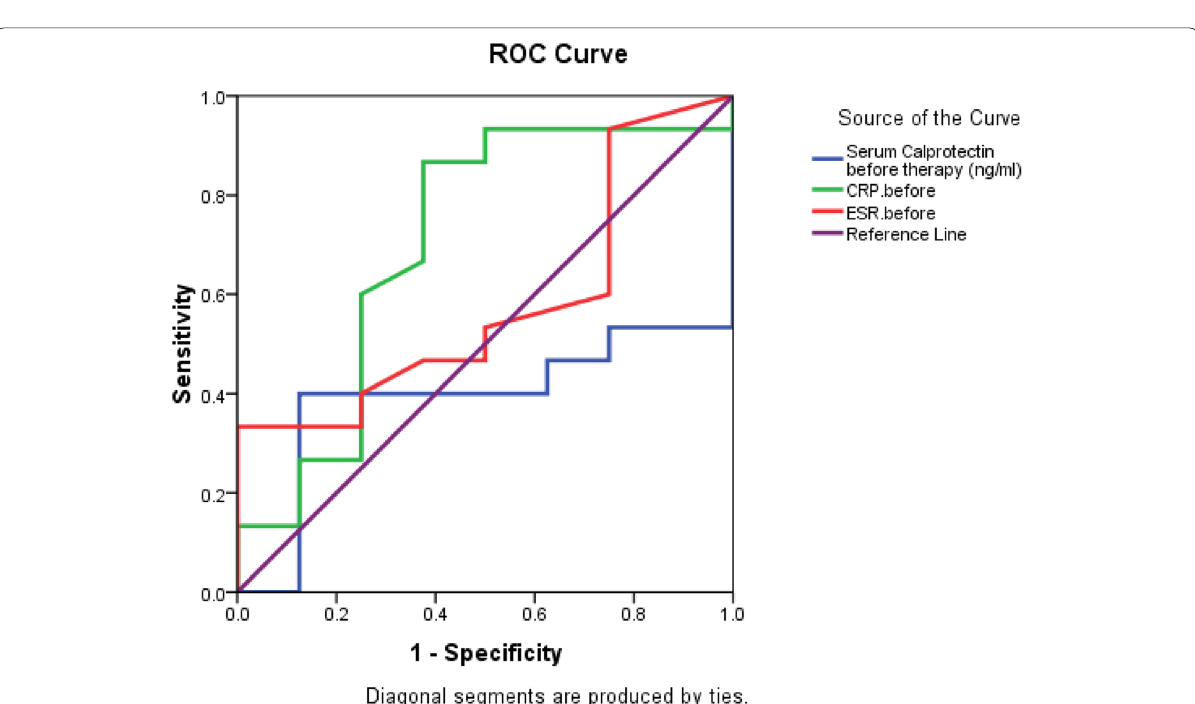
Fig. 5 Receiver operating characteristic (ROC) curve for serum calprotectin levels, CRP and ESR to discriminate patients with high and moderate disease activity. The ROC analysis showed that at a cutoff point of 397.05 ng/ml, calprotectin showed a maximum AUC of 0.608 (95% CI 0.372– 0.845); P 0.401, whereas CRP at a cutoff point of 60 mg/l showed an AUC 0.704 (95% CI 0.457–0.952); P 0.114. Besides, ESR at a cutoff point of = = = 67.5 mm/h had an AUC 0.579 (95% CI 0.336–0.823); P = =